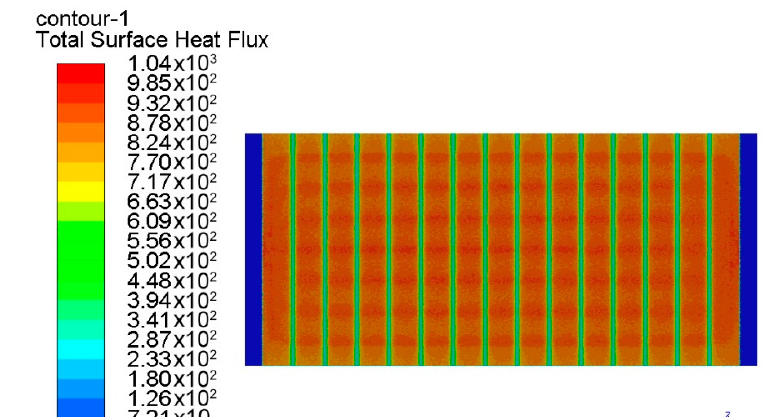
Figure 18. Line location for heat flux extraction.